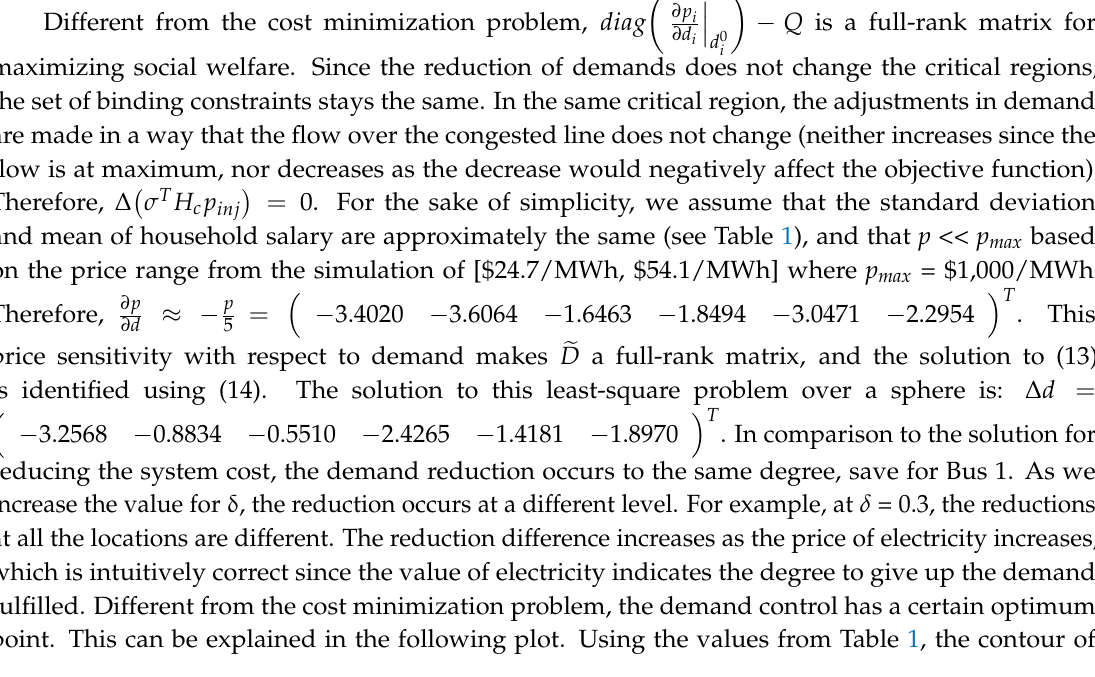
Figure 8. Equi-cost contour plots as a function of two variable loads in the IEEE 30-bus system; Bus 1 and 4.